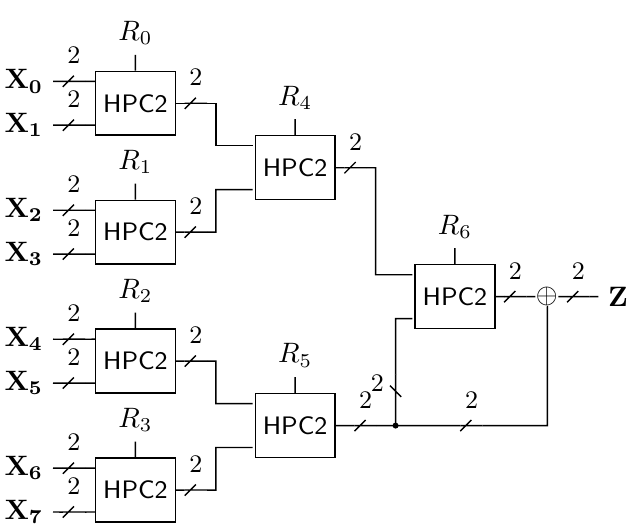
Figure 1: Example for a circuit composed of first-order HPC2 AND